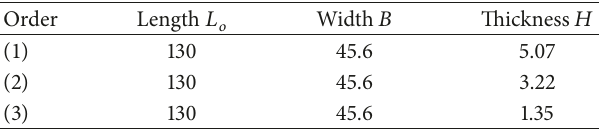
Table 5: Geometric parameters of the blade are simplified as cantilever